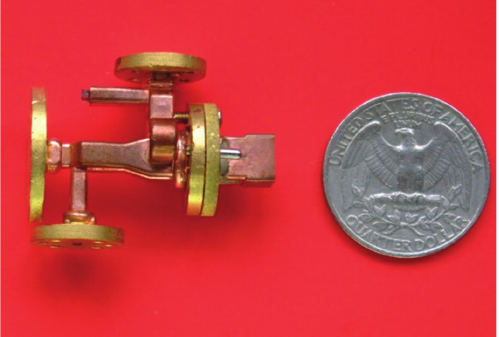
Figure 11: Photo of sum-di ff erence device with horn.